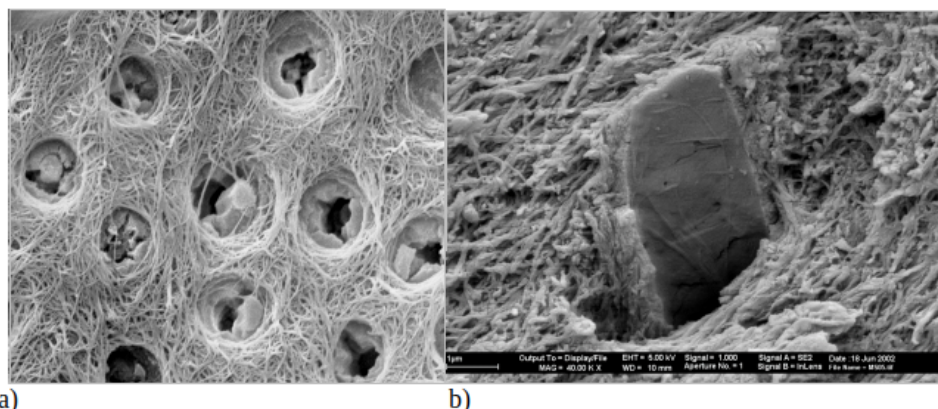
Figure 2. Overview of the structure of dentine showing the complex tubule features as well as microtubules through the peri-tubular mineralised